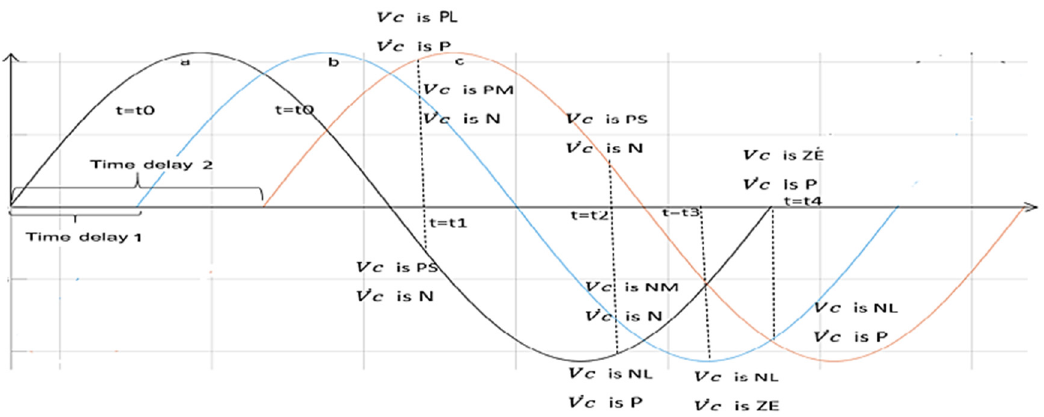
Figure 11. Time-delay signal of Vc. Table 6. Rule based on delay-compensated FLWADC.